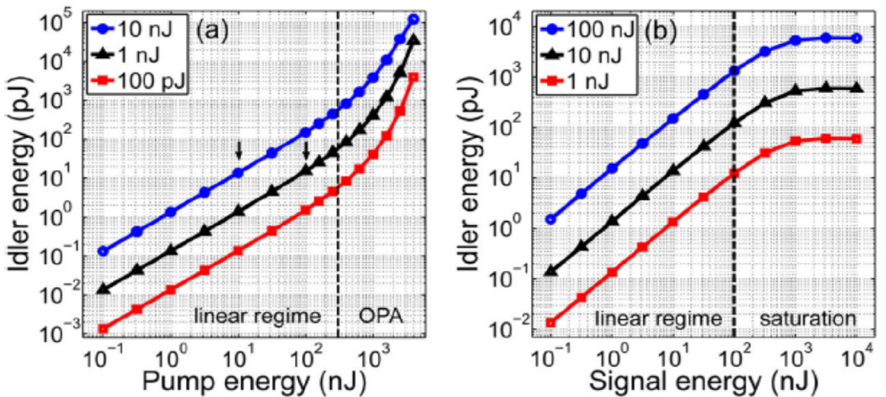
Figure 10. Energy evolution curve of idler pulse energy obtained through theoretical calculations. Reprinted with permission from [142] © The Optical Society. ( a ) Evolution of the idler energy versus the input pump energy when the input signal energy is fixed at 100 pJ, 1 nJ, and 10 nJ. ( b ) Evolution of the idler energy versus the input pump energy when the input signal energy is fixed at 1 nJ, 10 nJ, and 100 nJ. The thickness of GaSe crystal for MIR generation is 2